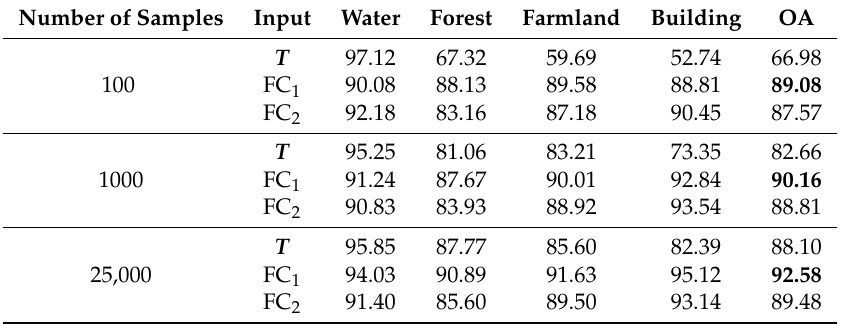
Table 7. The semi-supervised classification accuracies of RS-2 Flevoland (%). Number of